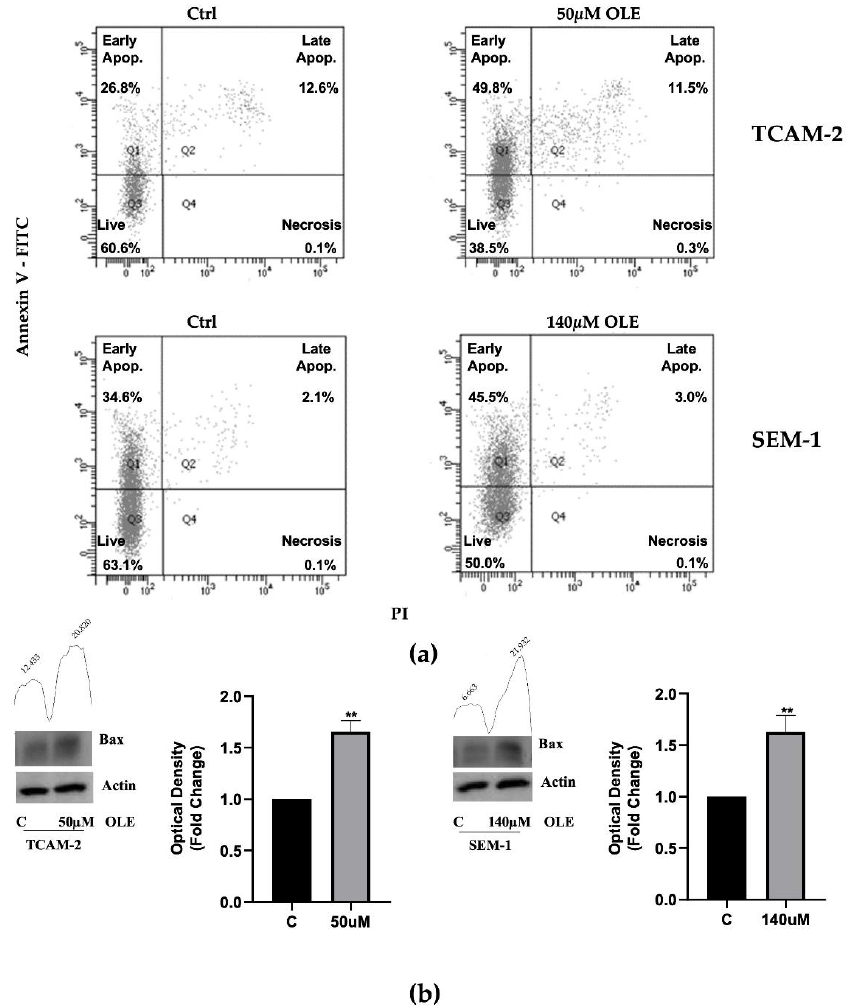
Figure 2. ( a ) An annexin V/PI assay was performed on SEM-1 and TCAM-2 cells using flow cytometry analysis. The following percentages of cells are represented in the figure: viable cells in the bottom left (PI/Annexin − / − ; Q 3 ), early apoptotic cells in the top left (PI/Annexin − /+; Q 1 ), late apoptotic cells in the top right (PI/Annexin +/+; Q 2 ), and necrotic cells in bottom right (PI/Annexin +/ − ; Q 4 ). ( b ) Immunoblotting showing Bax protein expression in TCAM-2 and SEM-1 cells exposed for 48 h to 50 µM and 140 µM of OLE, respectively. β -Actin was used as the loading control. The histograms represent the mean ± SD of three separate experiments (each performed in triplicate) in which the band intensities were evaluated as the optical density and are represented as fold change for treated vs. untreated cells normalized for the loading control. The numbers on the peaks reported on the top of each blot represent the size of the corresponding slot as a percentage of the total size of the two slots in each condition. ** p < 0.001 treated vs. untreated